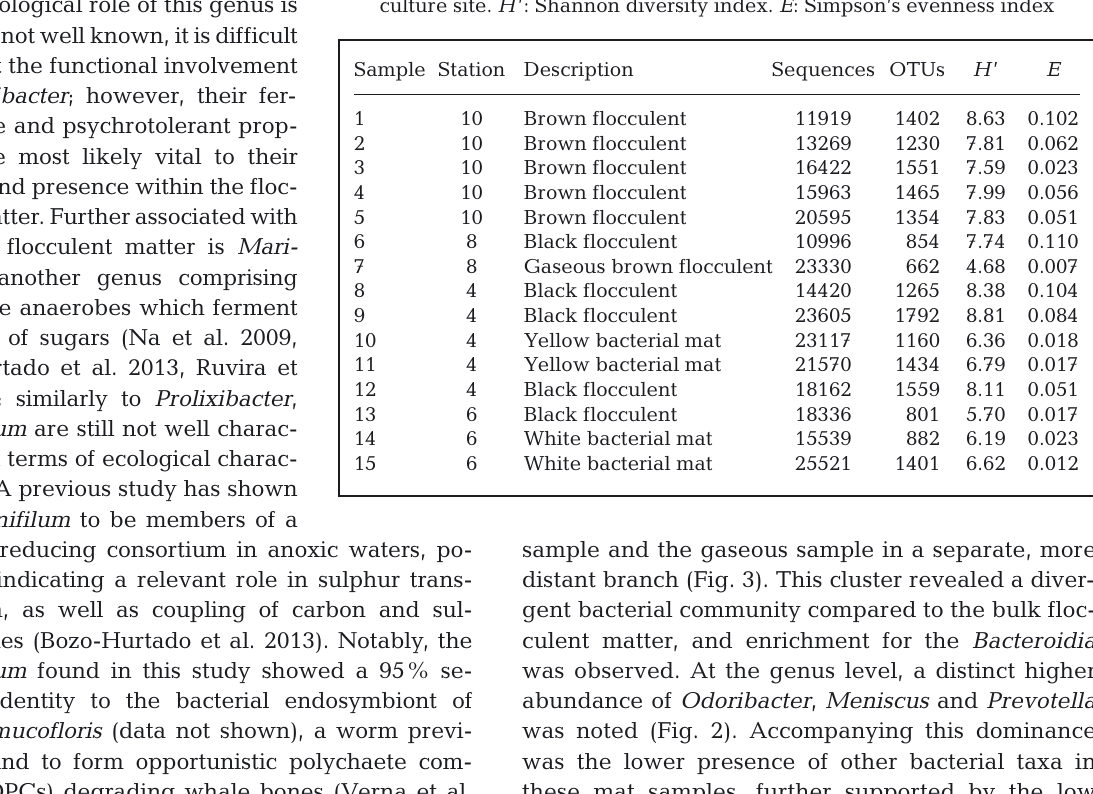
Table 1. Summary of high-throughput sequencing results. Displayed are the associated biological alpha-diversity parameters for bacterial and